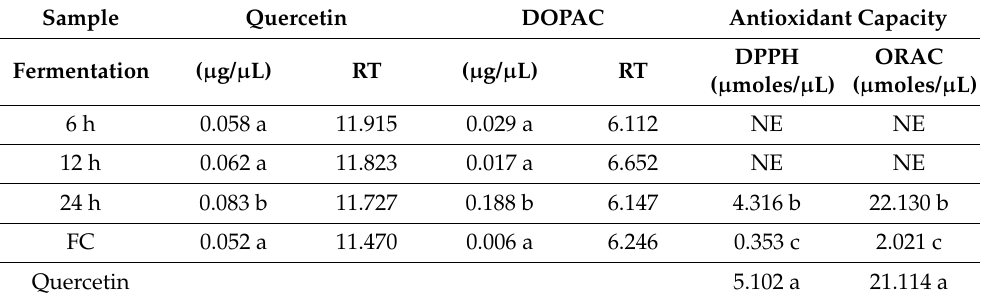
Table 1. Quercetin, polyphenols and antioxidant capacity in the in vitro colonic fermented quercetin